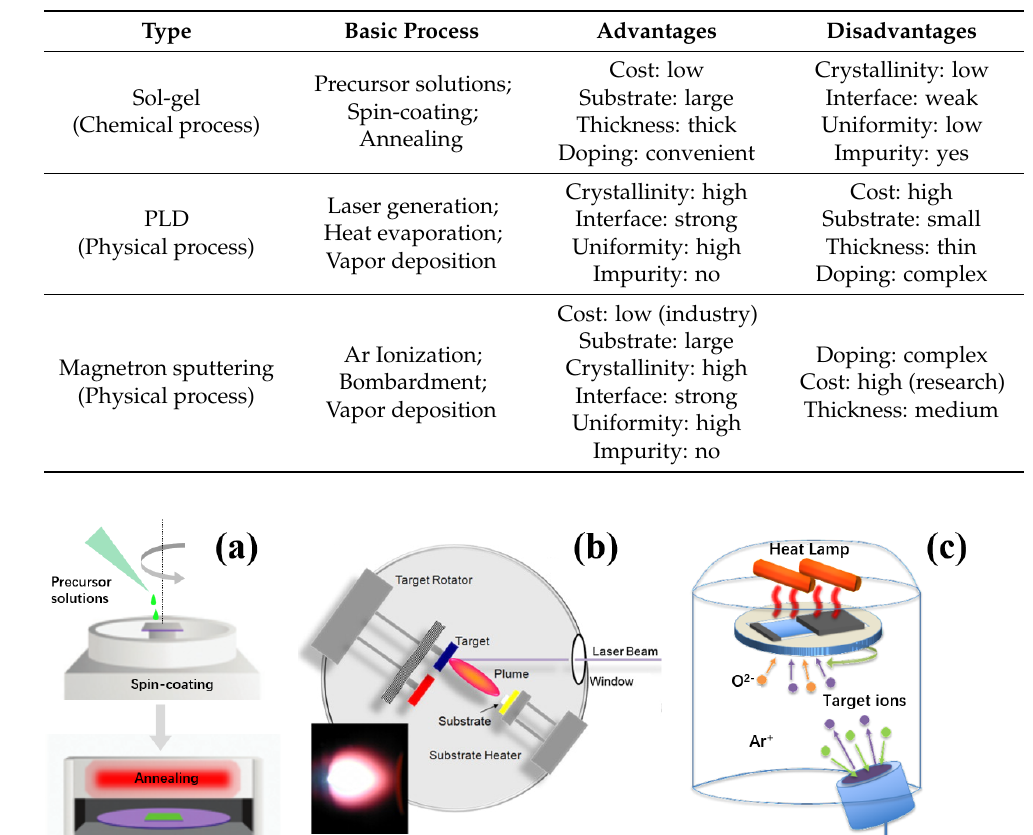
Table 1. Comparisons of sol-gel, pulsed laser deposition (PLD) and magnetron sputtering technique for the fabrication of PZT thin films.